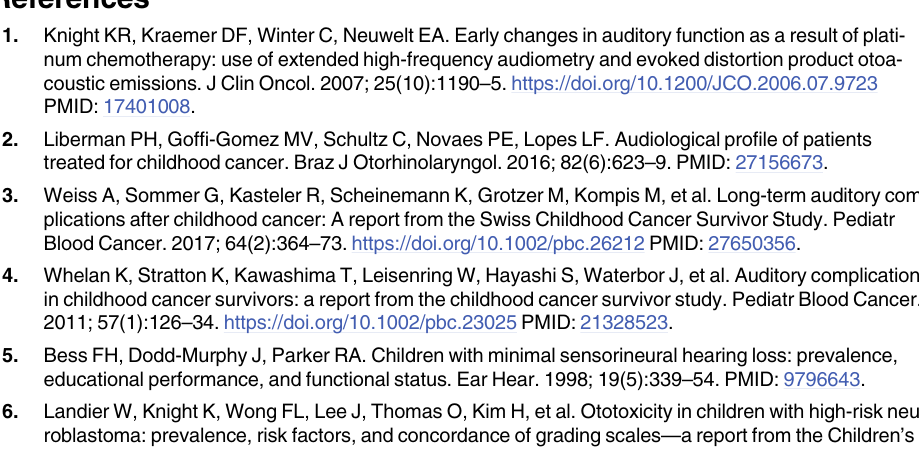
S2 Fig. Number of audiograms graded according to the U.S. National Cancer Institute Common Technology Criteria for Adverse Events version 4.03 (CTCAEv4.03), Brock, Chang, Muenster and SIOP grading